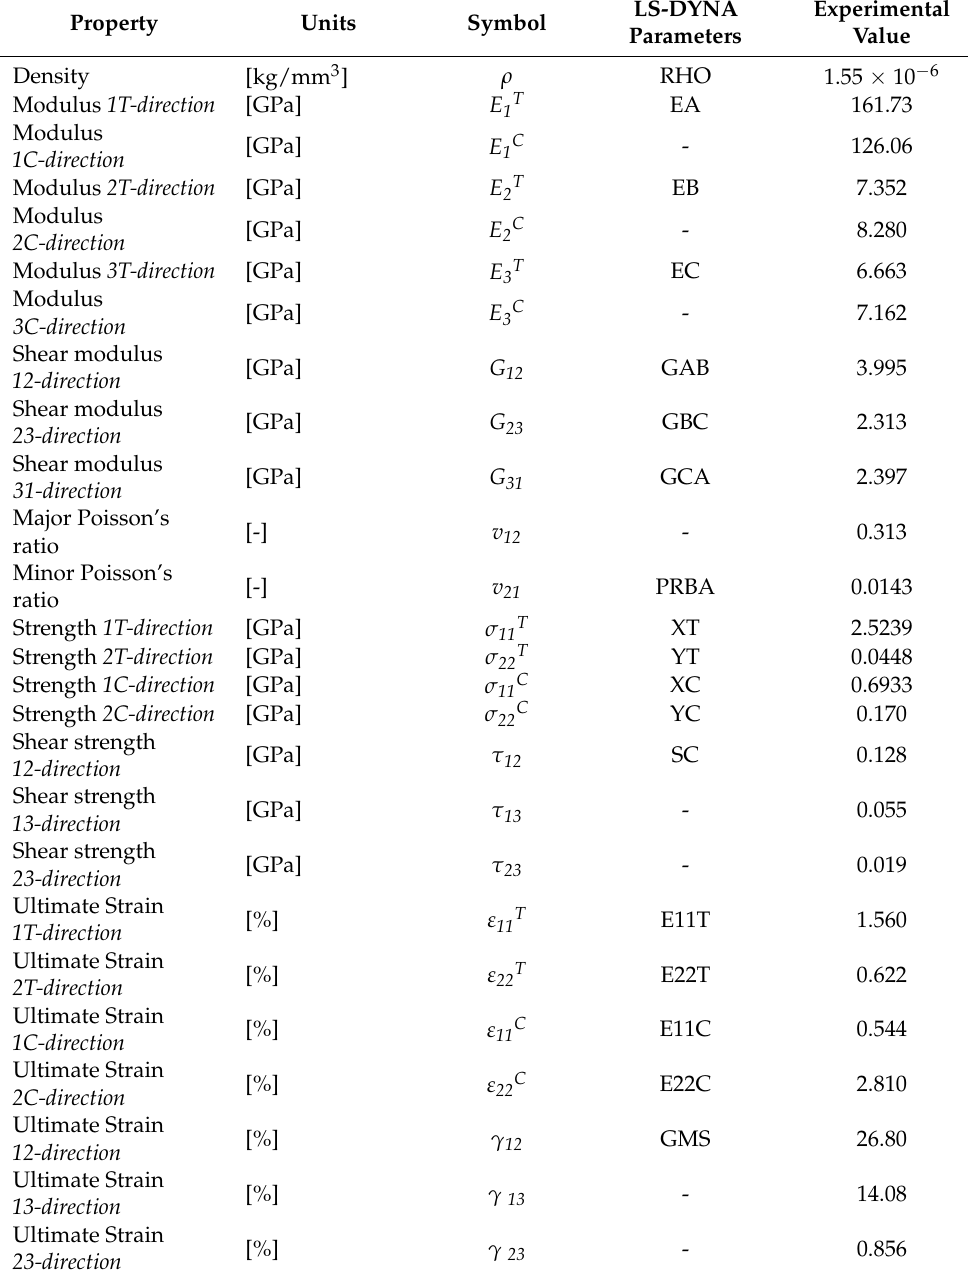
Table 1. Static material properties and associated strength threshold of T800/F3900 as published in [12] and relative nomenclature for